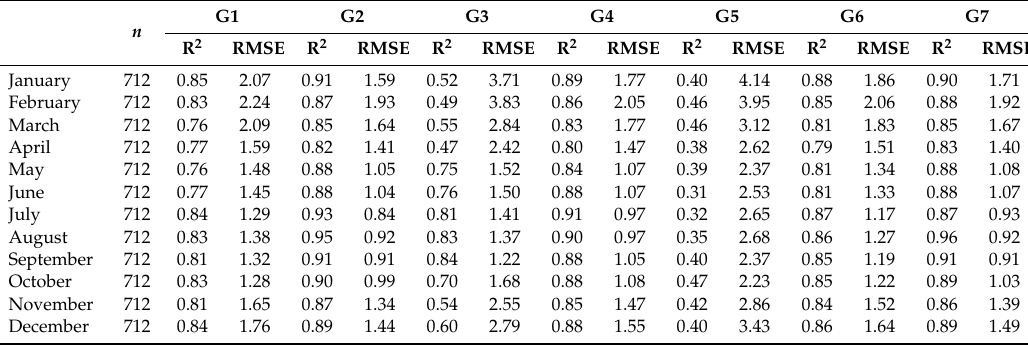
Table 4. Modeling results obtained using the RF regression. Reported are the monthly summary models for each of the seven groups of variables. For details of groupings G1 to G7, see Table 3. G1 G2 n